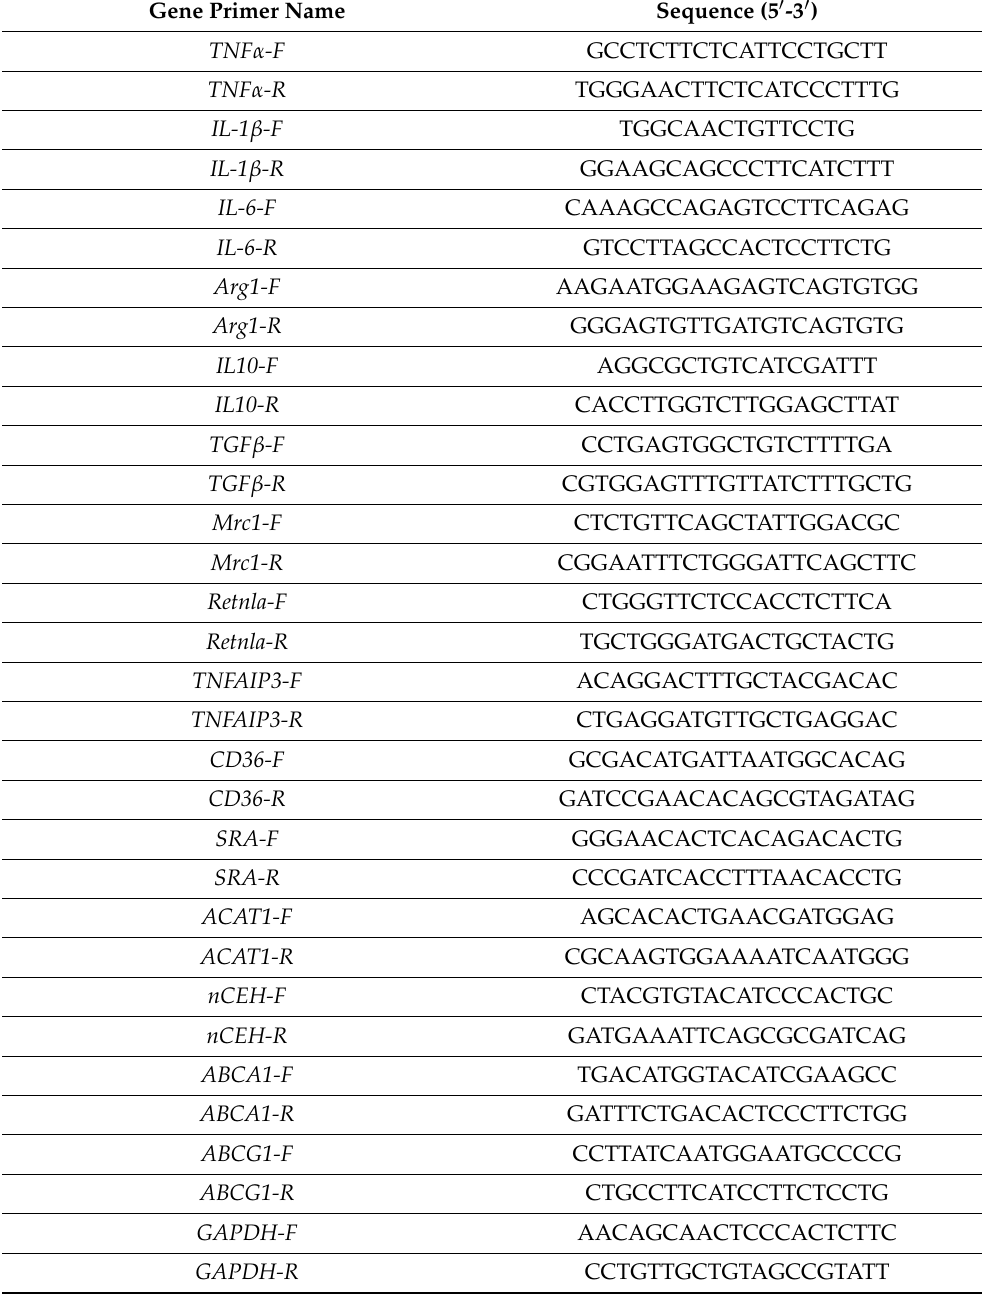
Table 1. Primers sequences used in this